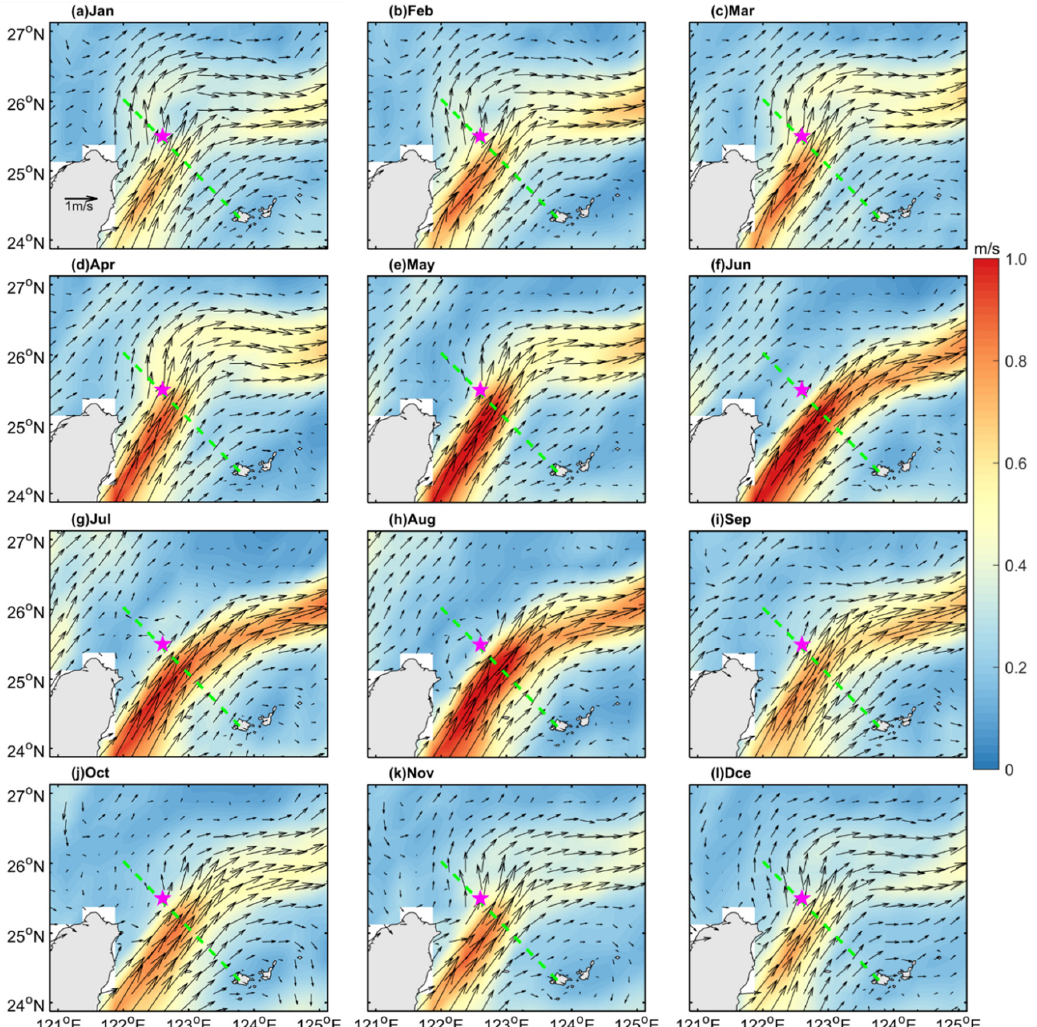
Figure 13. The climatological monthly sea surface geostrophic velocities (black arrows) and the corresponding geostrophic velocity amplitudes (color) off northeastern Taiwan over the whole observation periods based on the satellite altimeter data. The magenta pentagrams denote average location of the mooring; the green dashed lines denote the section Q to calculate the Kuroshio axis position, ( a – l ) January–December.